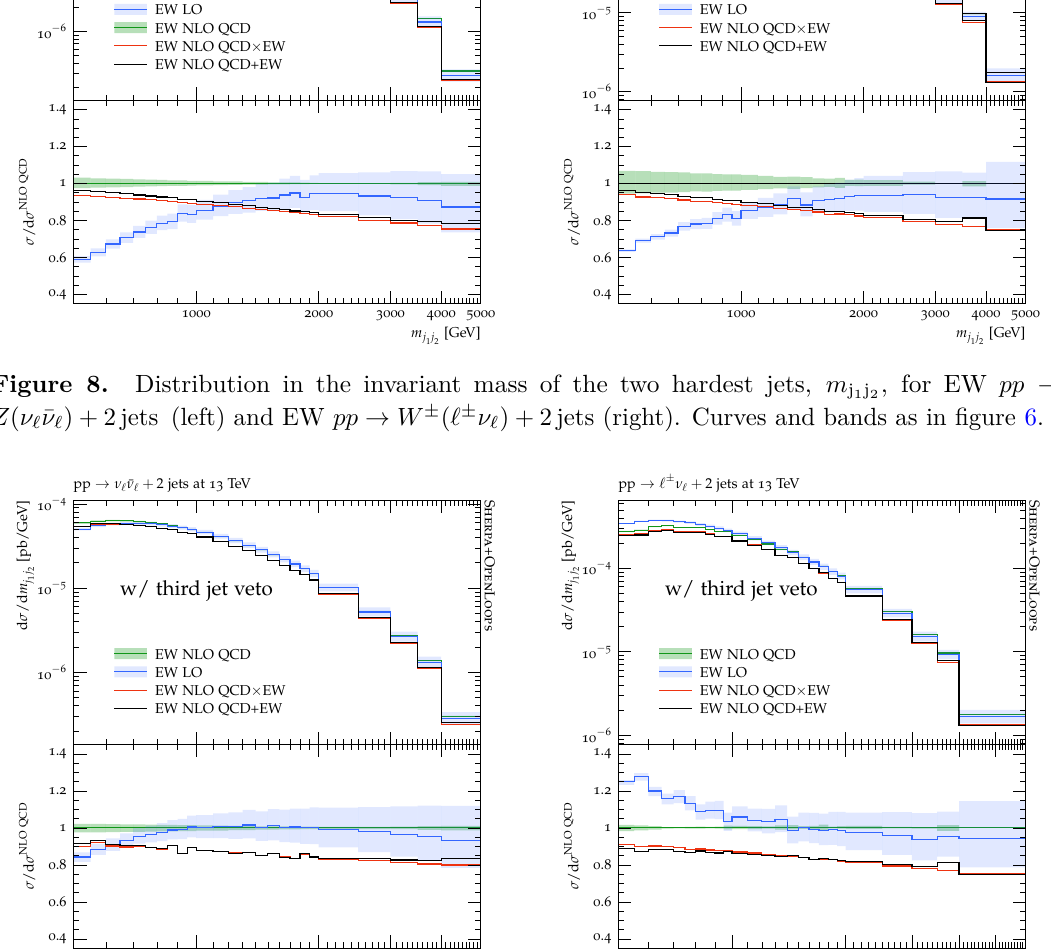
, for EW pp → 1 j 2